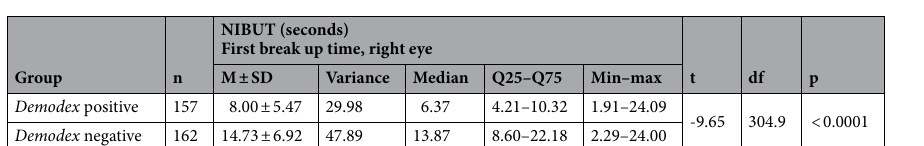
t df pM ± SD Variance Median Q25–Q75